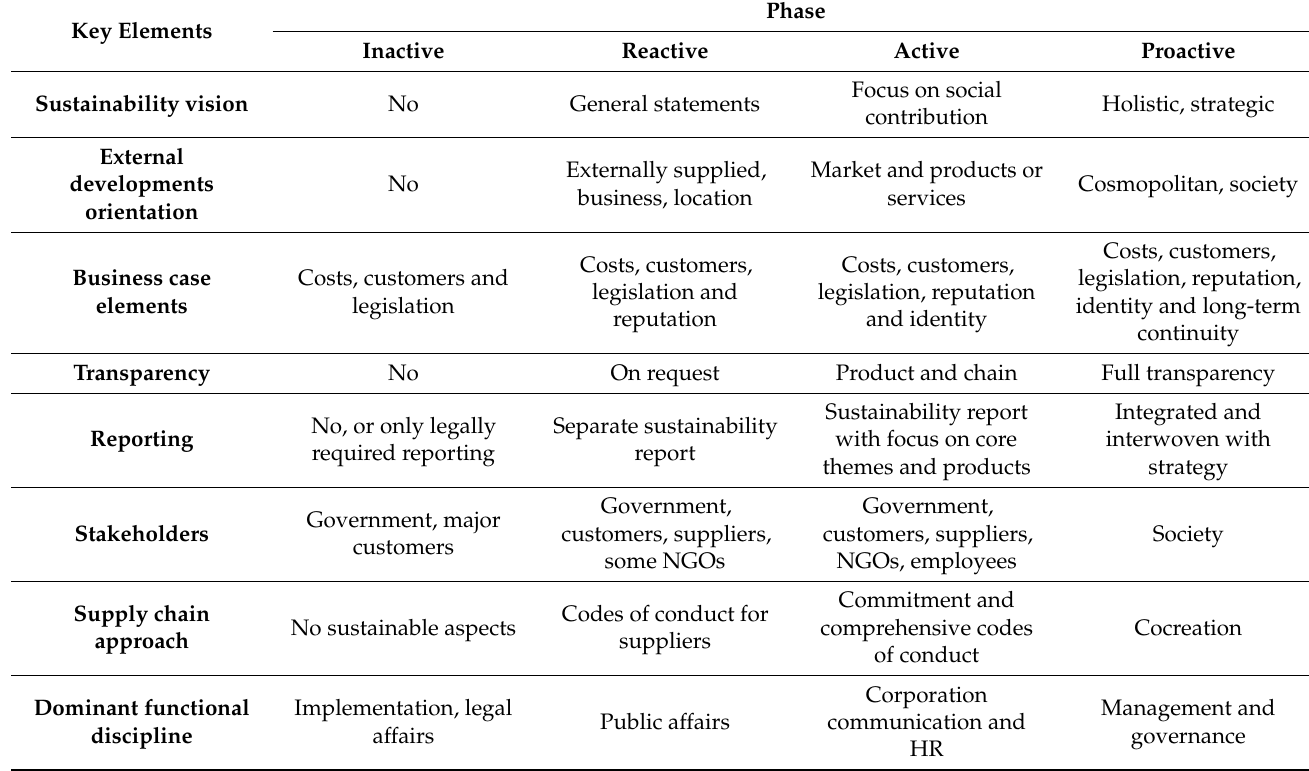
Table 2. Synthesis of the key elements of the four-stage model of sustainable entrepreneurship based on [12,14]. Key